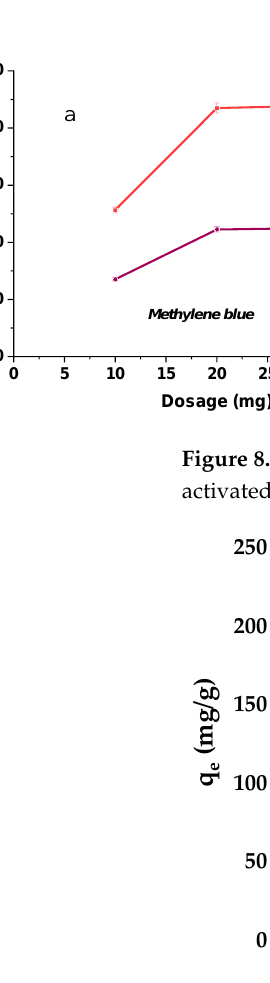
Figure 9. Effect of agitation rate on the adsorption of organic dyes on activated carbon.